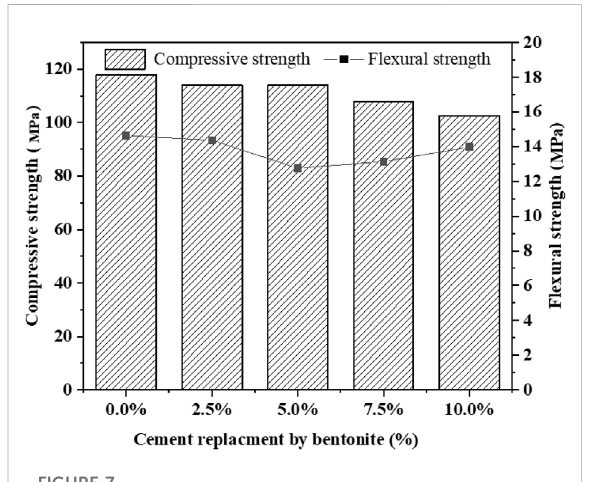
FIGURE 7 Compressive strength and fl exural strength of UHPC matrix.